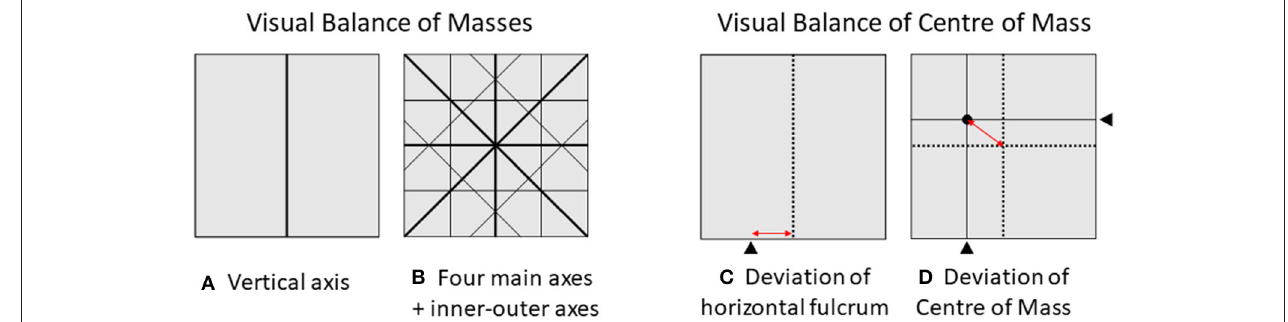
FIGURE 5 | These examples illustrate the calculation of the visual balance measures. (A) Balance along the vertical axis is the Symmetry SYM M . (B) The four main balance axes and their corresponding inner-outer dimensions for the calculation of BAL M . The eight axes are: vertical (verti), horizontal (hori), diagonal left top to right bottom (dia1), diagonal left bottom to right top (dia2), and their inner-outer counterparts (ioverti, iohori, iodia1, iodia2). (C) Horizontal center of mass and distance to geometrical center for calculation of SYM DCM . (D) Black fulcrums indicate the horizontal and vertical center of mass ( CM hori and CM verti ), the black dot indicates the center of mass, and the red arrow indicates the Euclidian distance of the center of mass from the geometrical midpoint of the frame. For an example of the center of mass and the resulting BAL DCM scores in photographs from the Instagram database see Figure A1 in the